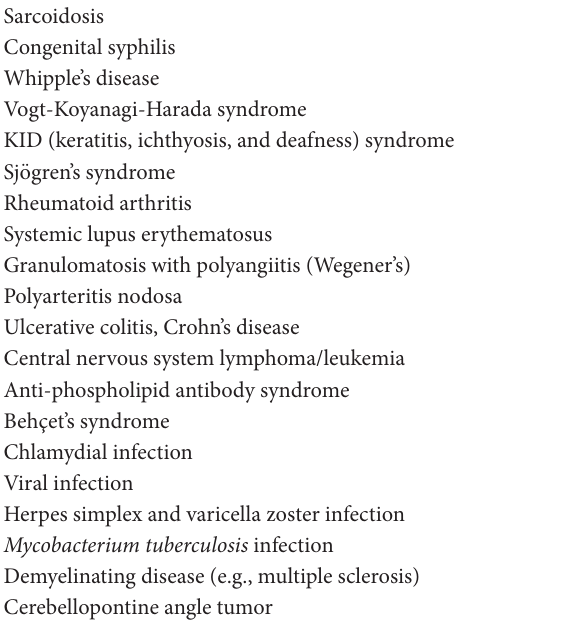
Table 1: Differential diagnosis of Cogan’s